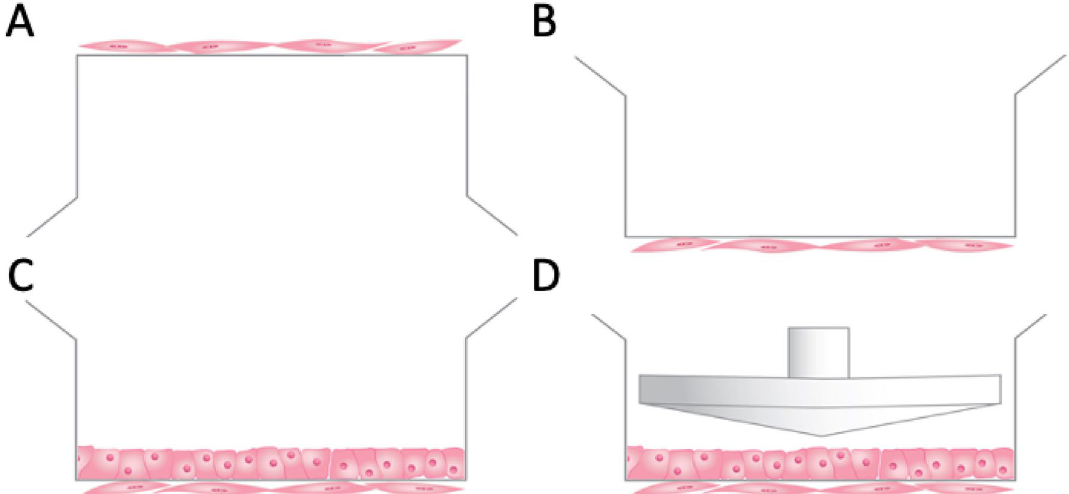
Figure 5. Illustration of in vitro co-culture model. ( A ) Transwell inserts were inverted and coated with gelation and HCASMC seeded onto the bottom of the insert. ( B ) After incubation overnight the iserts were reverted into 6 well plates overnight. ( C ) The top side of the insert was coat in gelatin and seeded with HCAEC and incubated overnight. ( D ) After a further overnight incubation in serum reduced media, cells were exposed to FSS using a microstepper driven